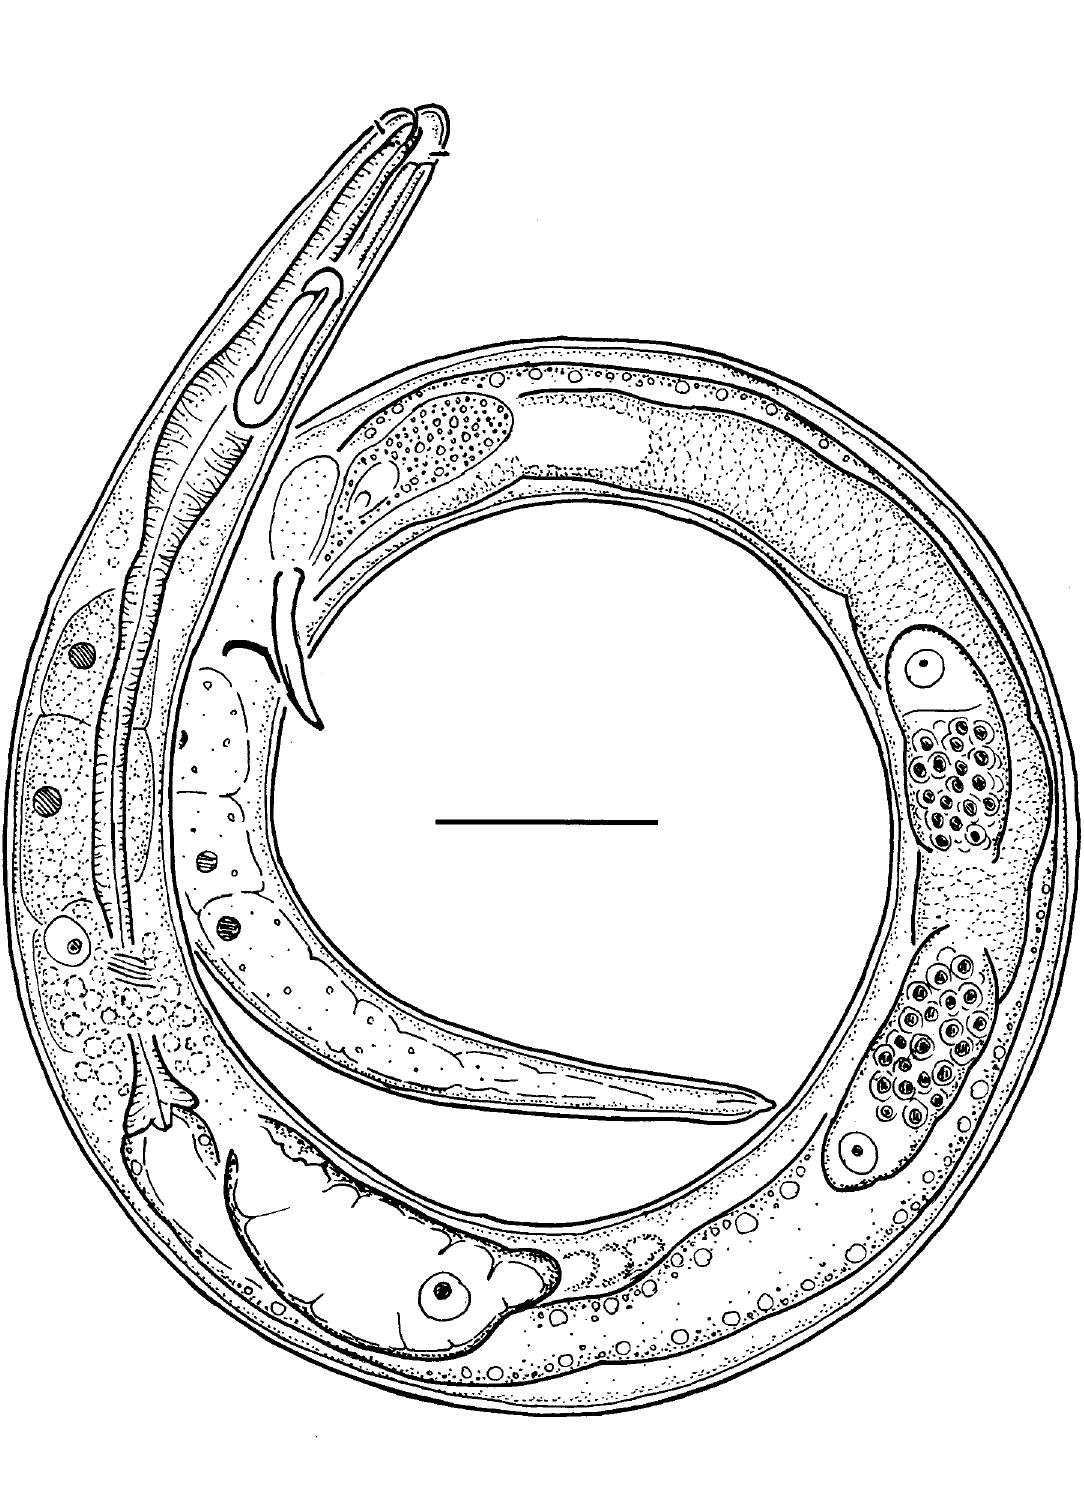
Fig. 2. Belgopeltula belgica (Vincx & Gourbault, 1992) gen. et comb. nov., male entire view. Scale bar = 20